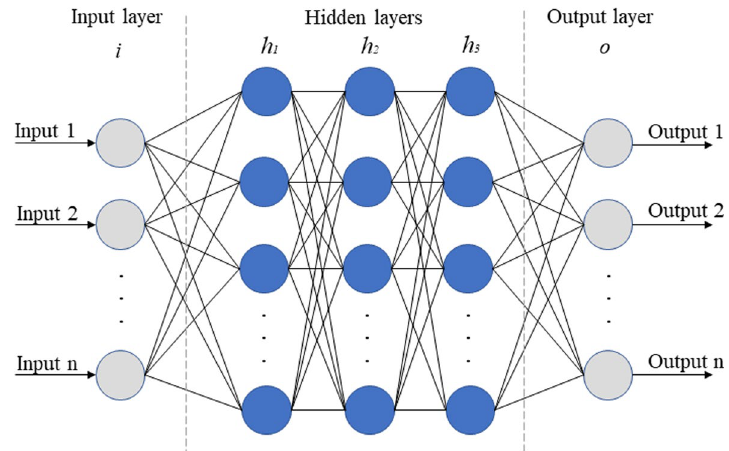
Fig. 4 Basic MLP